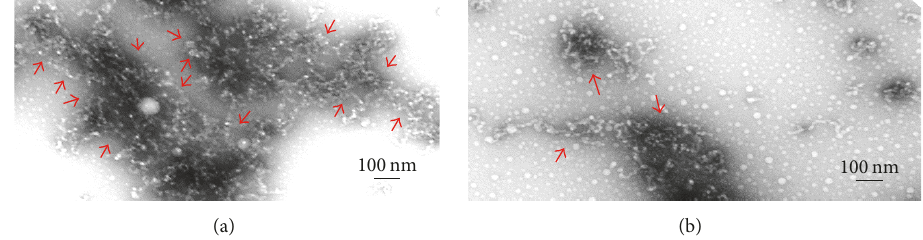
Figure 6: TEM of 𝛽 -amyloid. (a) 𝛽 -Amyloid (PBS); (b) 𝛽 -amyloid (10 𝜇 g/ml OPP). (a) shows the large A 𝛽 42 aggregates and meshes (size greater than 10 nm) which form in the absence of OPP. (b) shows the smaller aggregates which are more sparse which form in the presence of 10 𝜇 g/ml